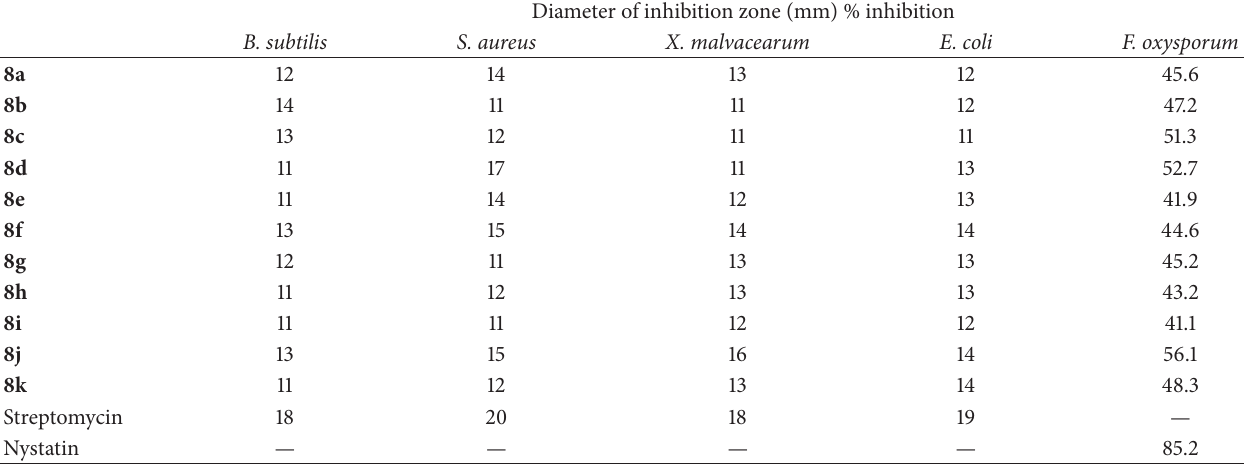
Table 2: In vitro antibacterial and antifungal activities of synthesized